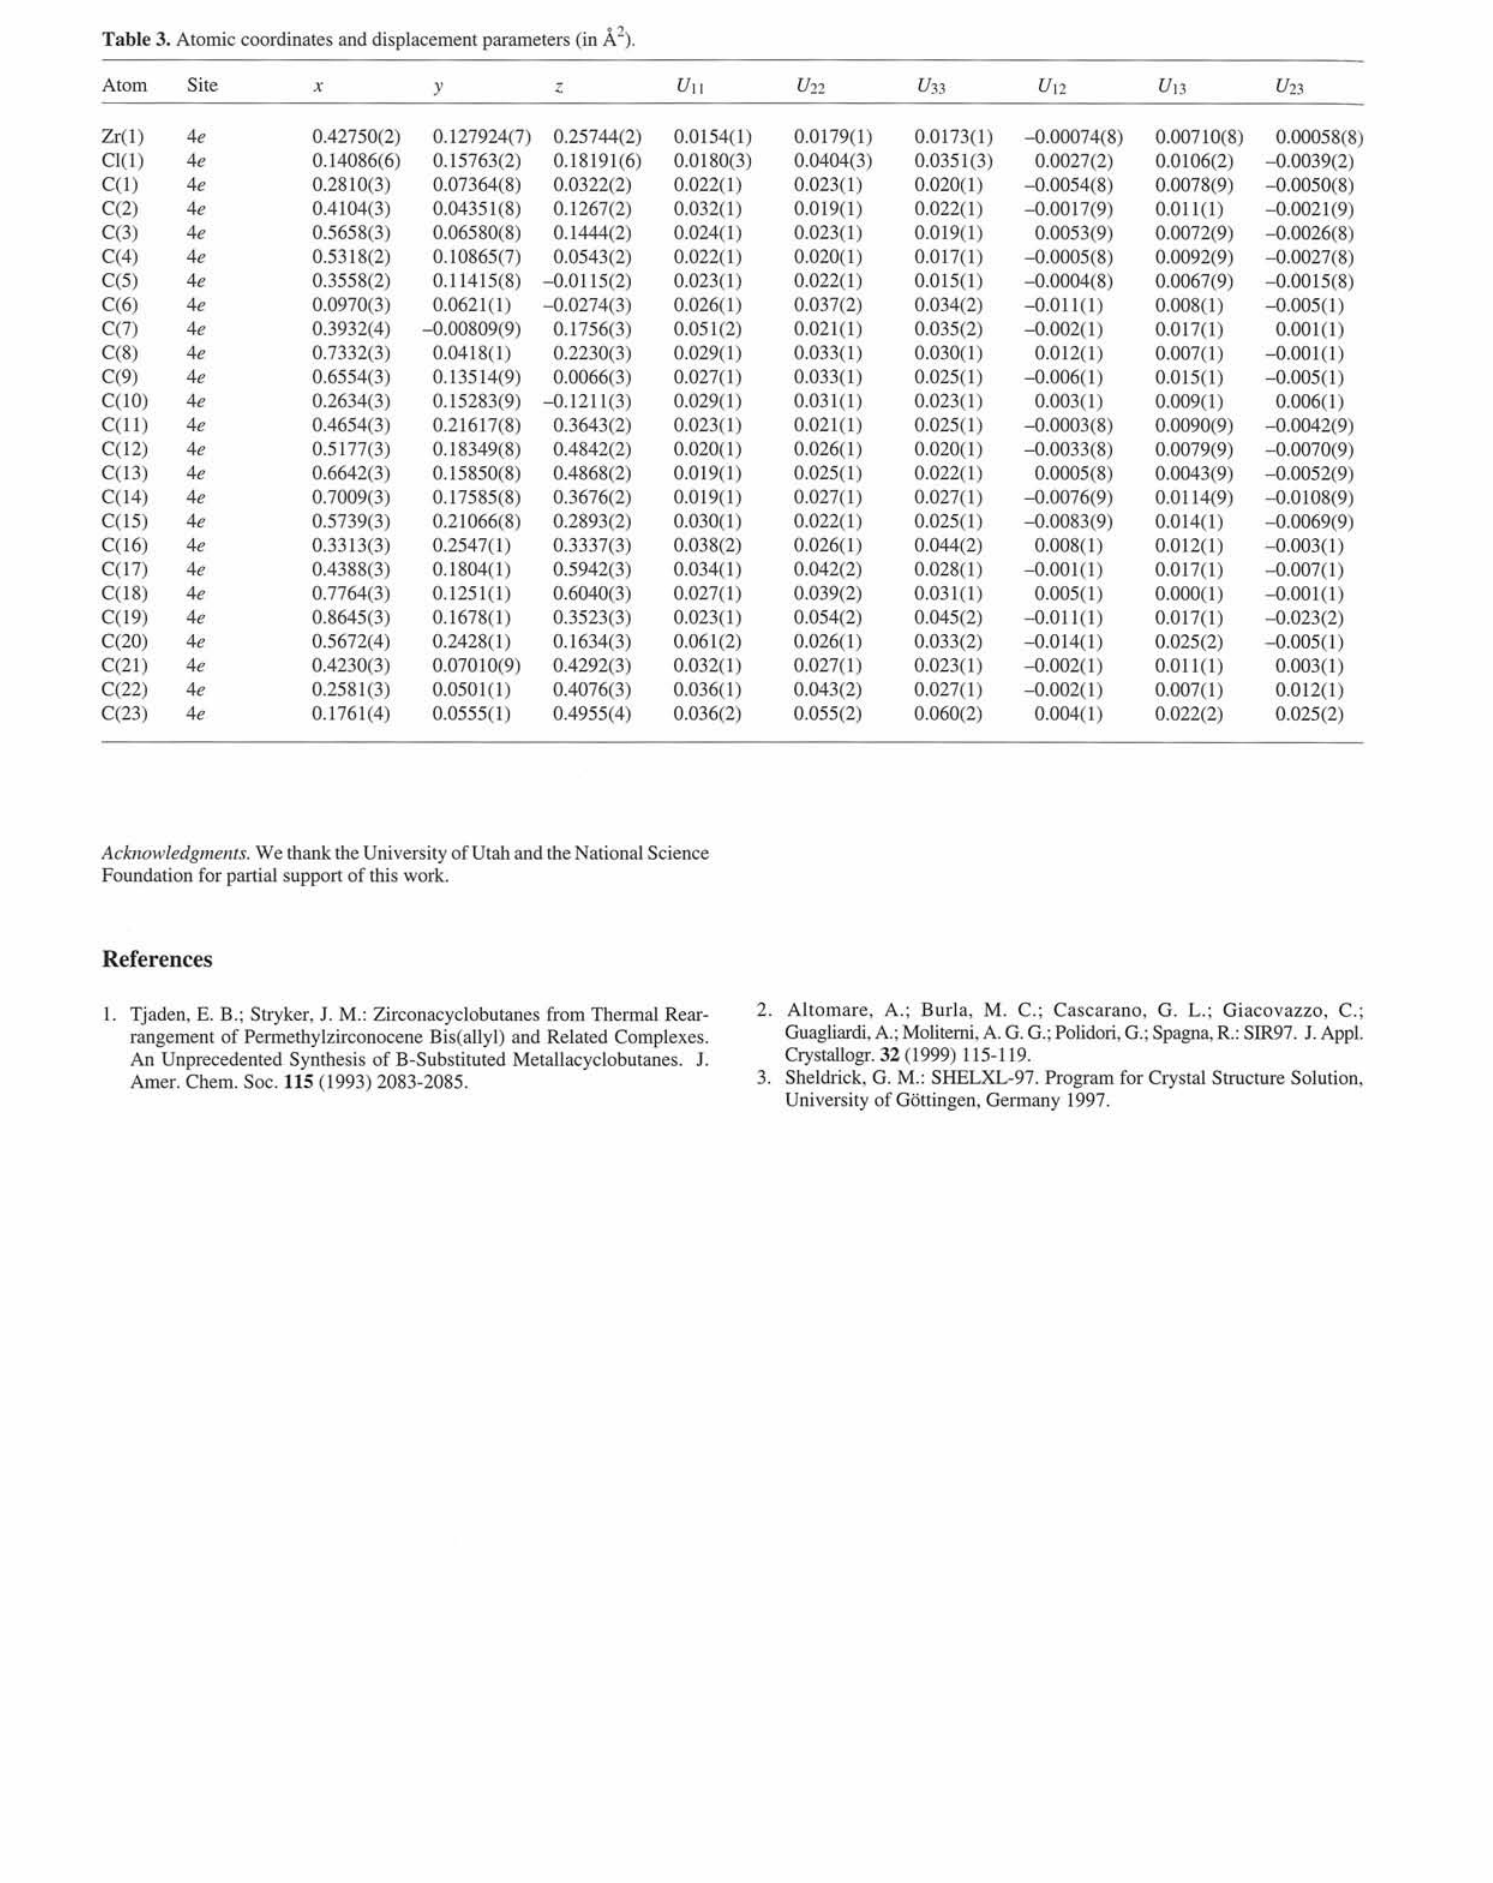
Table 3. Atomic coordinates and displacement parameters (in Â 2